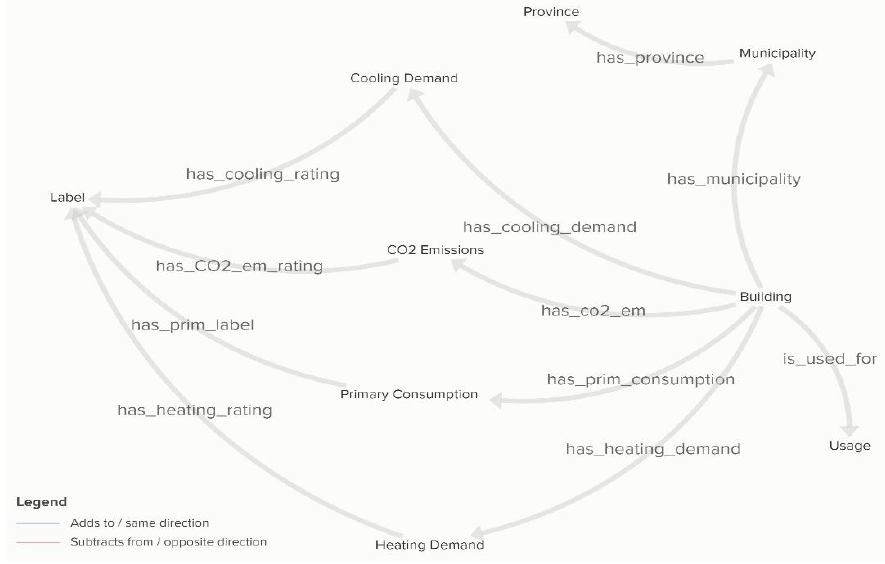
Figure 7. EREN data stored in Neo4j.